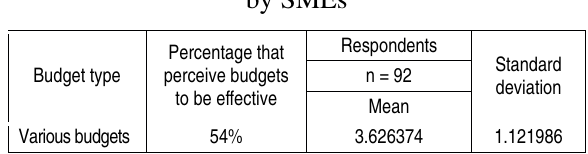
Table 5. Perceived effectiveness of budgets